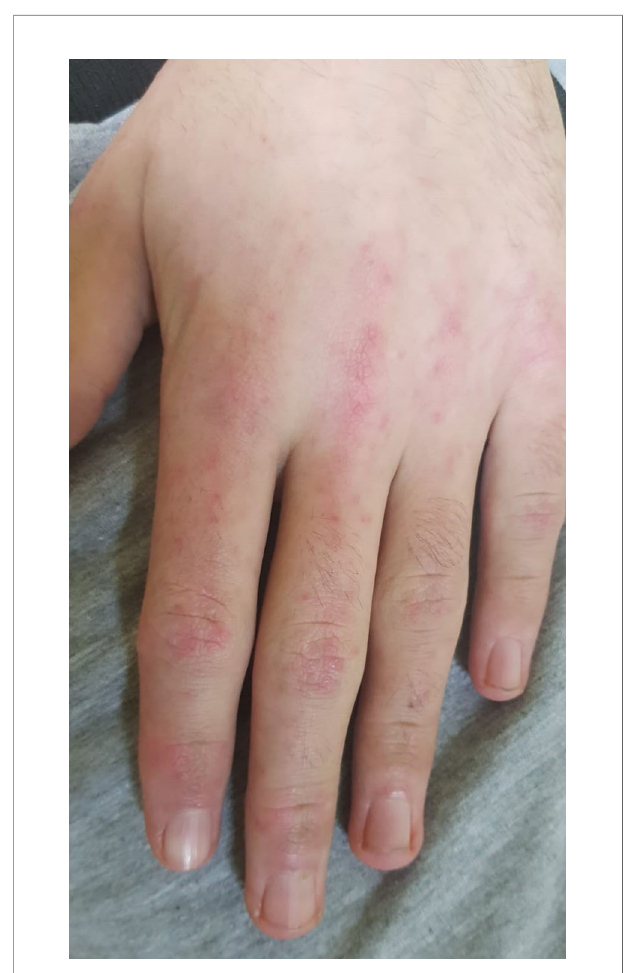
FIGURE 1 | Characteristic cutaneous features of DM called Gottron ’ s papules (multiple erythematous papules over the dorsal aspect of metacarpophalangeal and interphalangeal